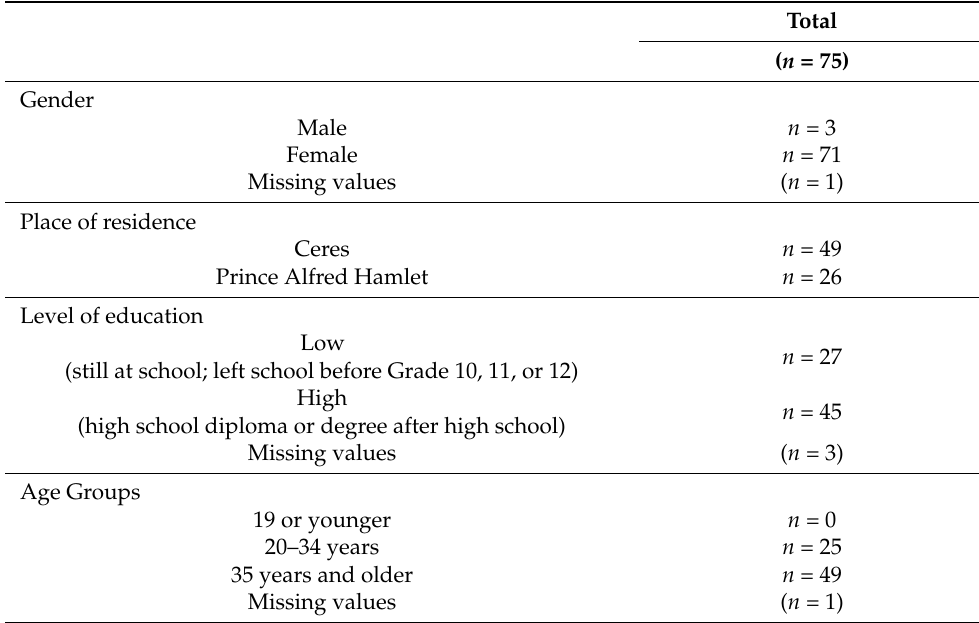
Table 3. Descriptive statistics for the part of the study related to